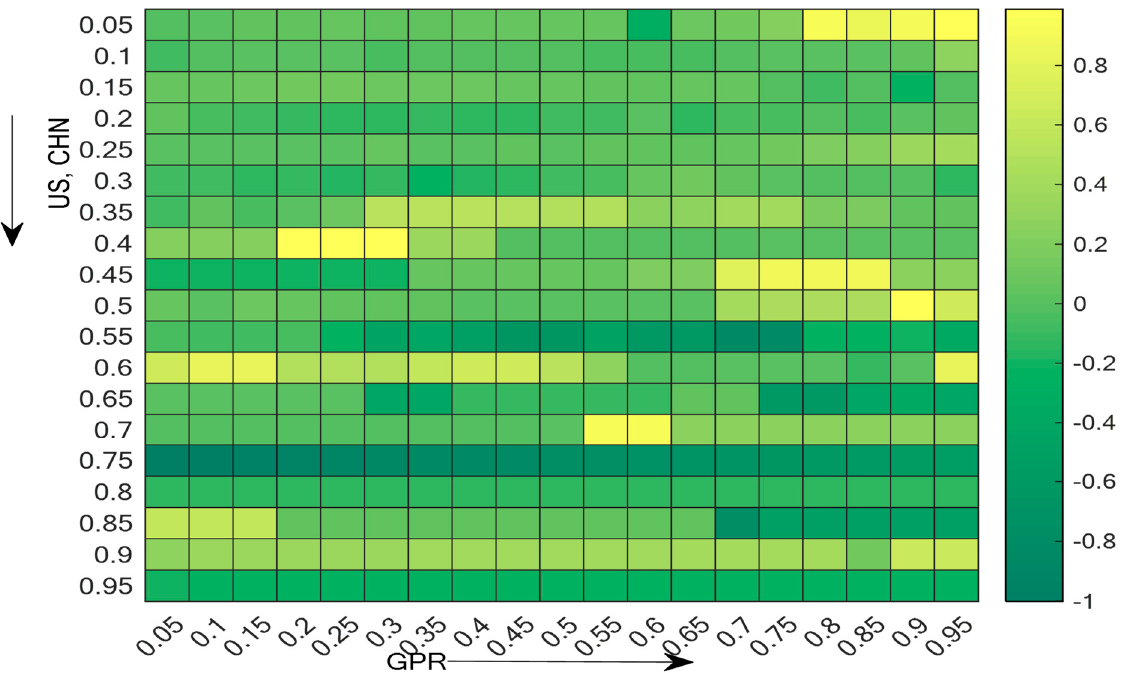
Figure 6. The response of US–RUS stock market synchronization to geopolitical risk. Note: The horizontal axis indicates the quantile of GPR, whereas the vertical axis is the quantile of stock market synchronization in ascending order. The right-side color bar indicates the intensity of the response of synchronization to GPR. The dark green and yellow colors indicate negative and positive responses and synchronization to GPR, respectively.